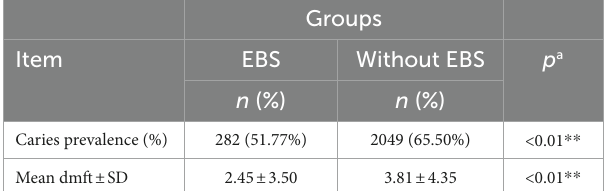
TABLE 5 Association between the mean dmft value\caries prevalence and extrinsic black stain (EBS) in 2,331 children in Wenzhou, China.